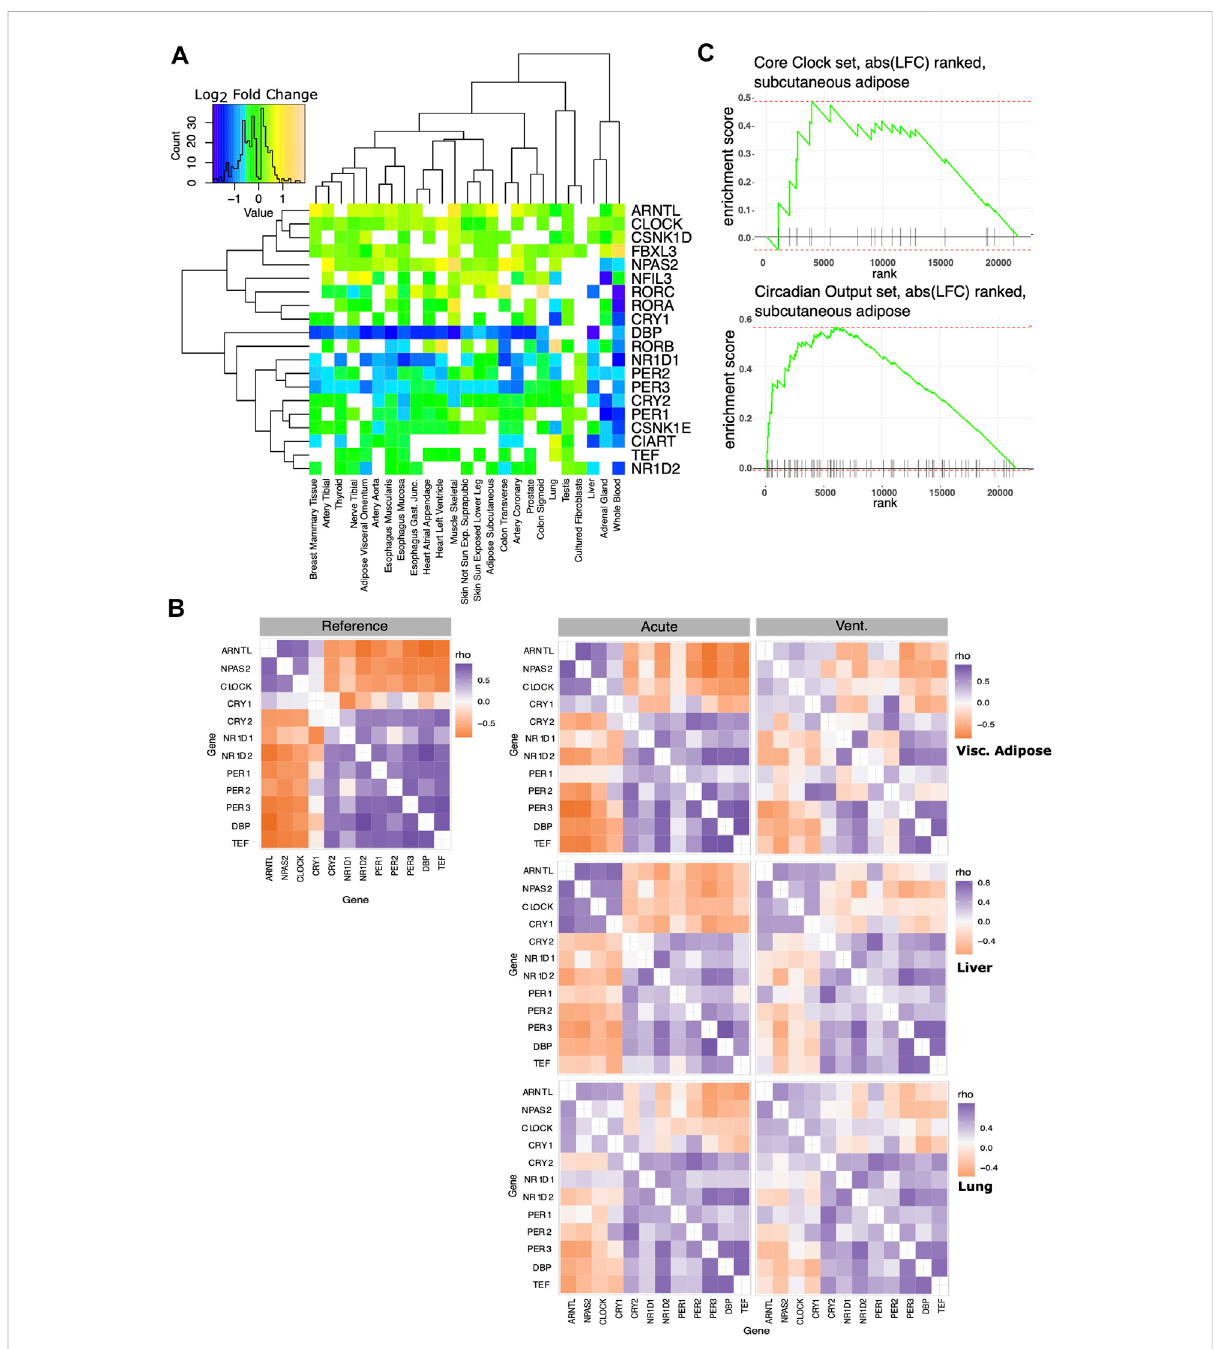
FIGURE 3 Effectofcriticalcareoncore clockorganizationandcircadianoutputgenes.Asetofcore clockgeneswastakenfromtheliterature(Ana fi etal., 2014; Shilts et al., 2018). (A) Log 2 fold changes of core circadian clock genes signi fi cantly differentially expressed between AD and IC groups shown acrosstissues.Notethatinmosttissues,mostcoreclockgenesshowaverysmallfoldchange.CCDmatricesassesscoreclockorganizationandco- expression. (B) Left: the reference correlation matrix, used to calculate the CCD metric. Right: Example Spearman correlation matrices of core circadian clock genes in visceral adipose, liver and lung tissue. Clock function in visceral adipose is markedly decreased in the IC group, liver tissue shows a more moderate effect. Δ CCD analysis does not suggest a change in pulmonary oscillator organization following IC. (C) We ranked genes based on the log fold change between the AD and IC groups in subcutaneous adipose tissue. This was compared to lists of core clock and robust circadian output genes using fGSEA. Enrichment plot for core clock set (top), does not show signi fi cant enrichment. Enrichment plot for the robust circadian output genes shows signi fi cant enrichment ( p < 0.01) as clock outputs were frequently ranked among the genes most strongly in fl uenced by